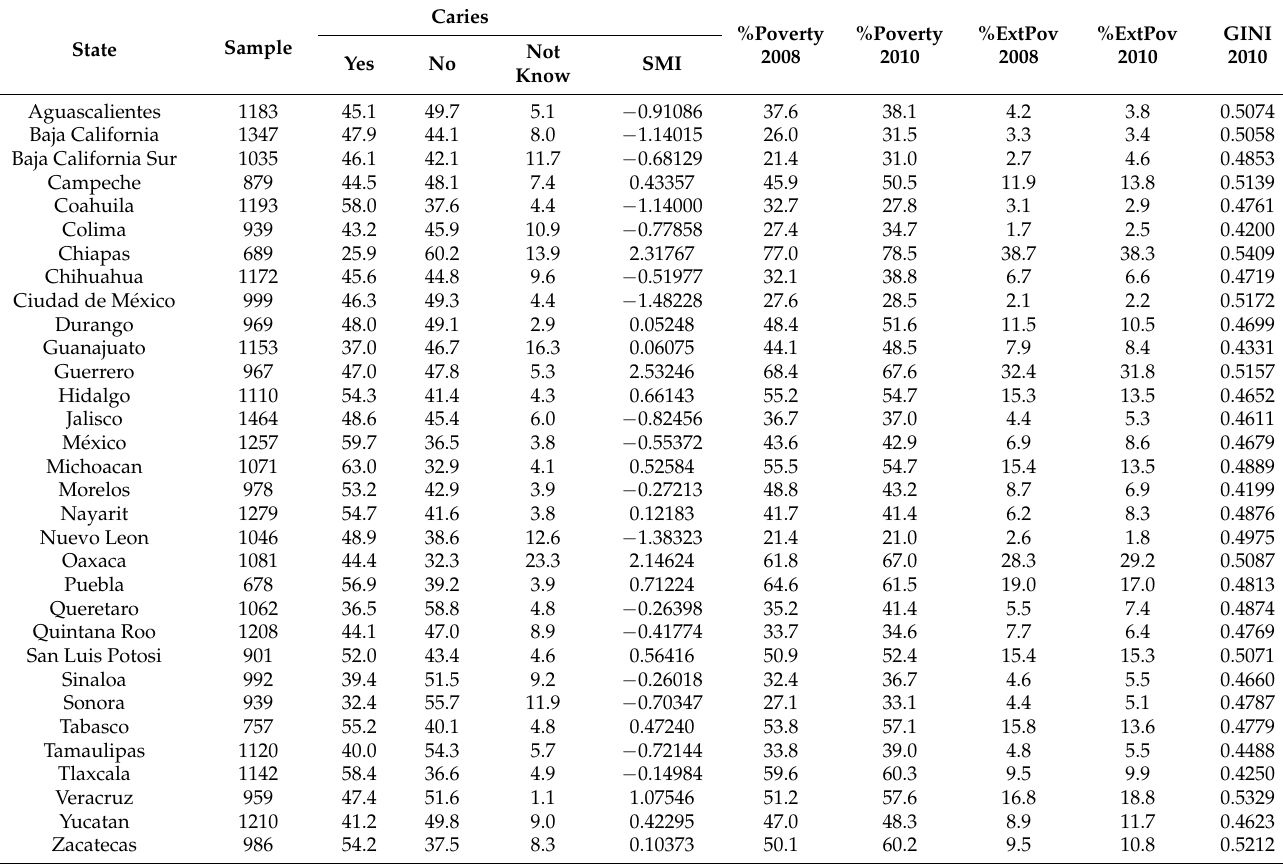
Table 1. State prevalence of caries self-reported in elementary schoolchildren in Mexico.